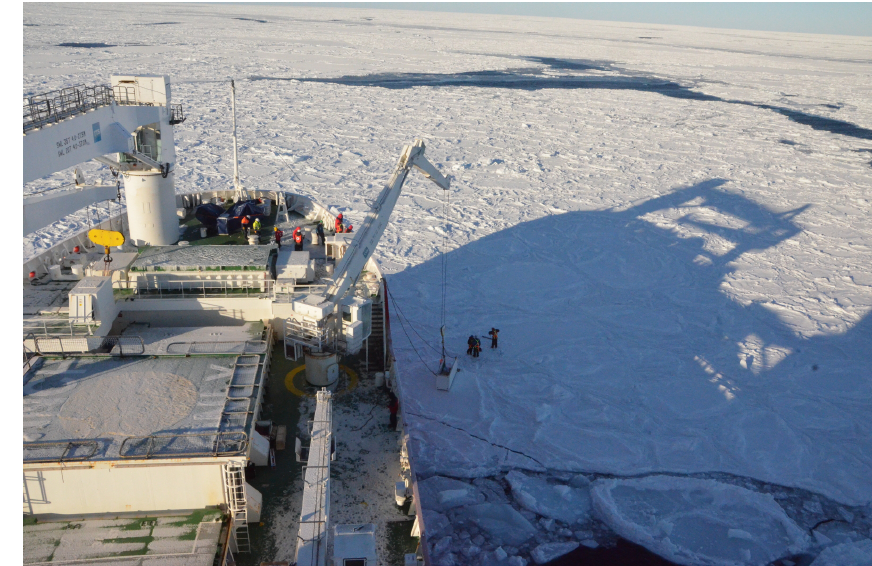
Figure 3. Coring field at MIZ3A showing the cemented pancakes with sizes varying between 3 and 15m.